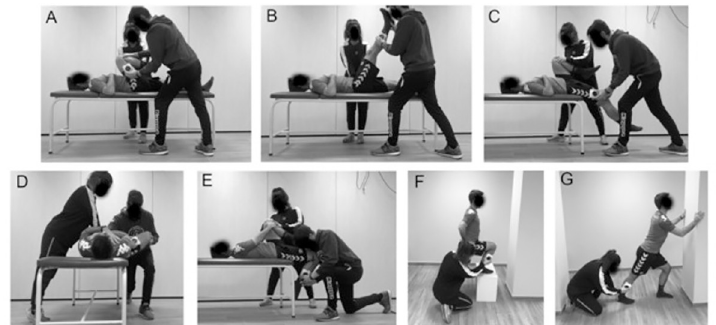
Fig 2. Lower limb passive range of motion testing. Positioning of the subjects performing passive ROM testing: (A) Passive hip flexion with flexed knee [HFFK]; (B) passive hip flexion with extended knee [HFEK]; (C) passive hip extension with flexed knee [HEFK]; (D) passive hip abduction with flexed knee [HAFK]; (E) passive knee flexion [KF]; (F) passive ankle dorsiflexion with flexed knee [ADFKF]; and (G) passive ankle dorsiflexion with extended knee [ADFKE].